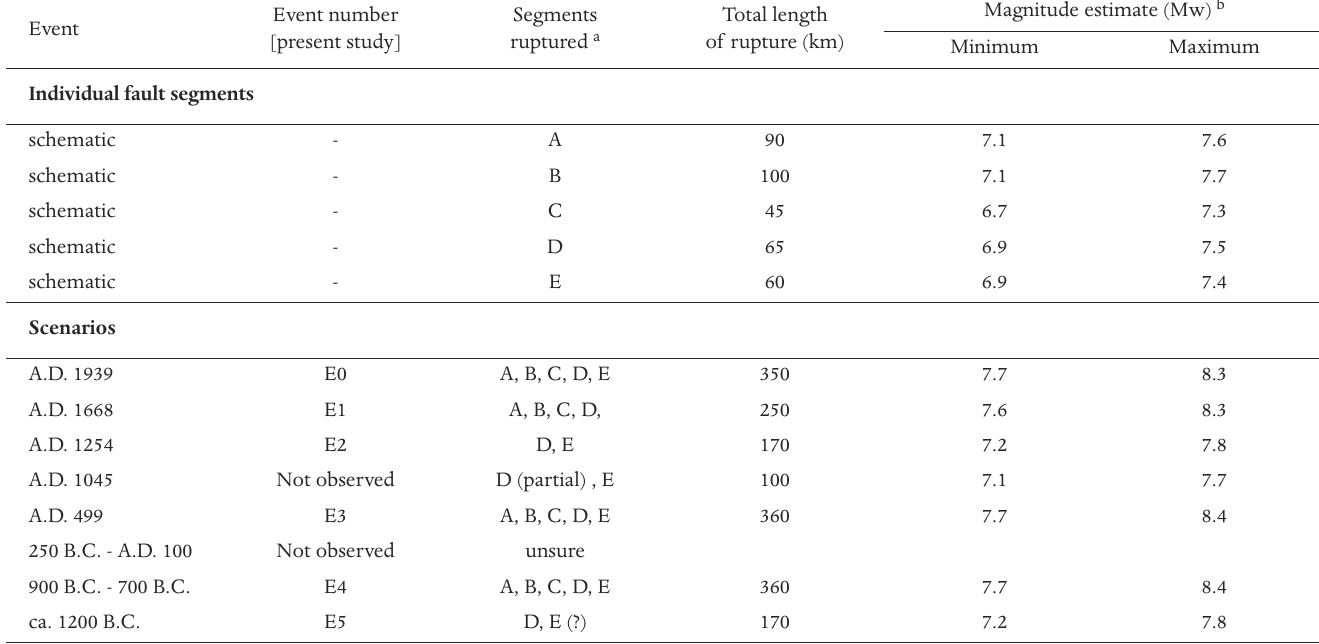
Table 5. Earthquake magnitude estimates for a range of rupture lengths. Note a , letters correspond to fault segments shown on Figure 1: A, Ezinepazari; B, Kelkit Valley; C, Ortakoy–Susehri; D, Mihar–Tumekar; E, Erzincan. Note b , magnitude estimated using formula and regression coefficients from Wells and Coppersmith [1994]; see text for